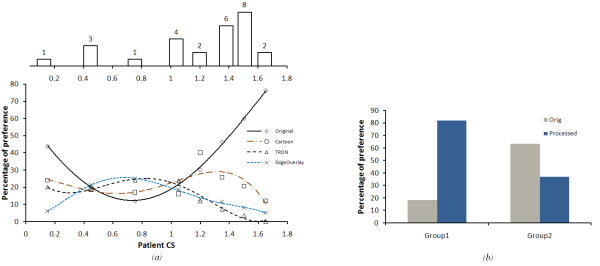
The patient's preference to each algorithm over the unprocessed images (Static scene). (a)the patient's preference to the processed and unprocessed images according to their CS. the distribution of patients according to their CS is shown above the figure. (b)the preference of image enhancement over the original for both groups who preferred the 70% of images in the processed format and the others who preferred the enhanced images less than 70%.